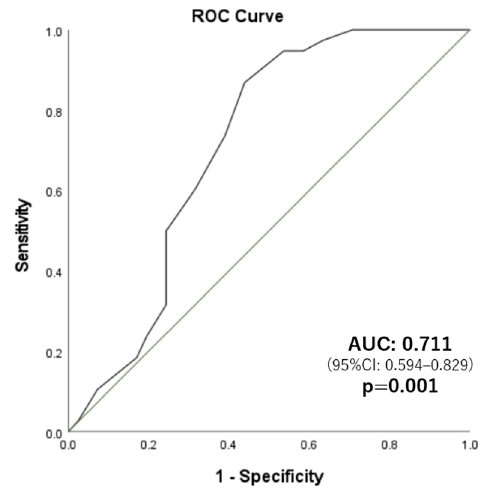
Figure 2. ROC analysis of cJOA score at 2 years postoperatively to predict PCS deterioration 2 years